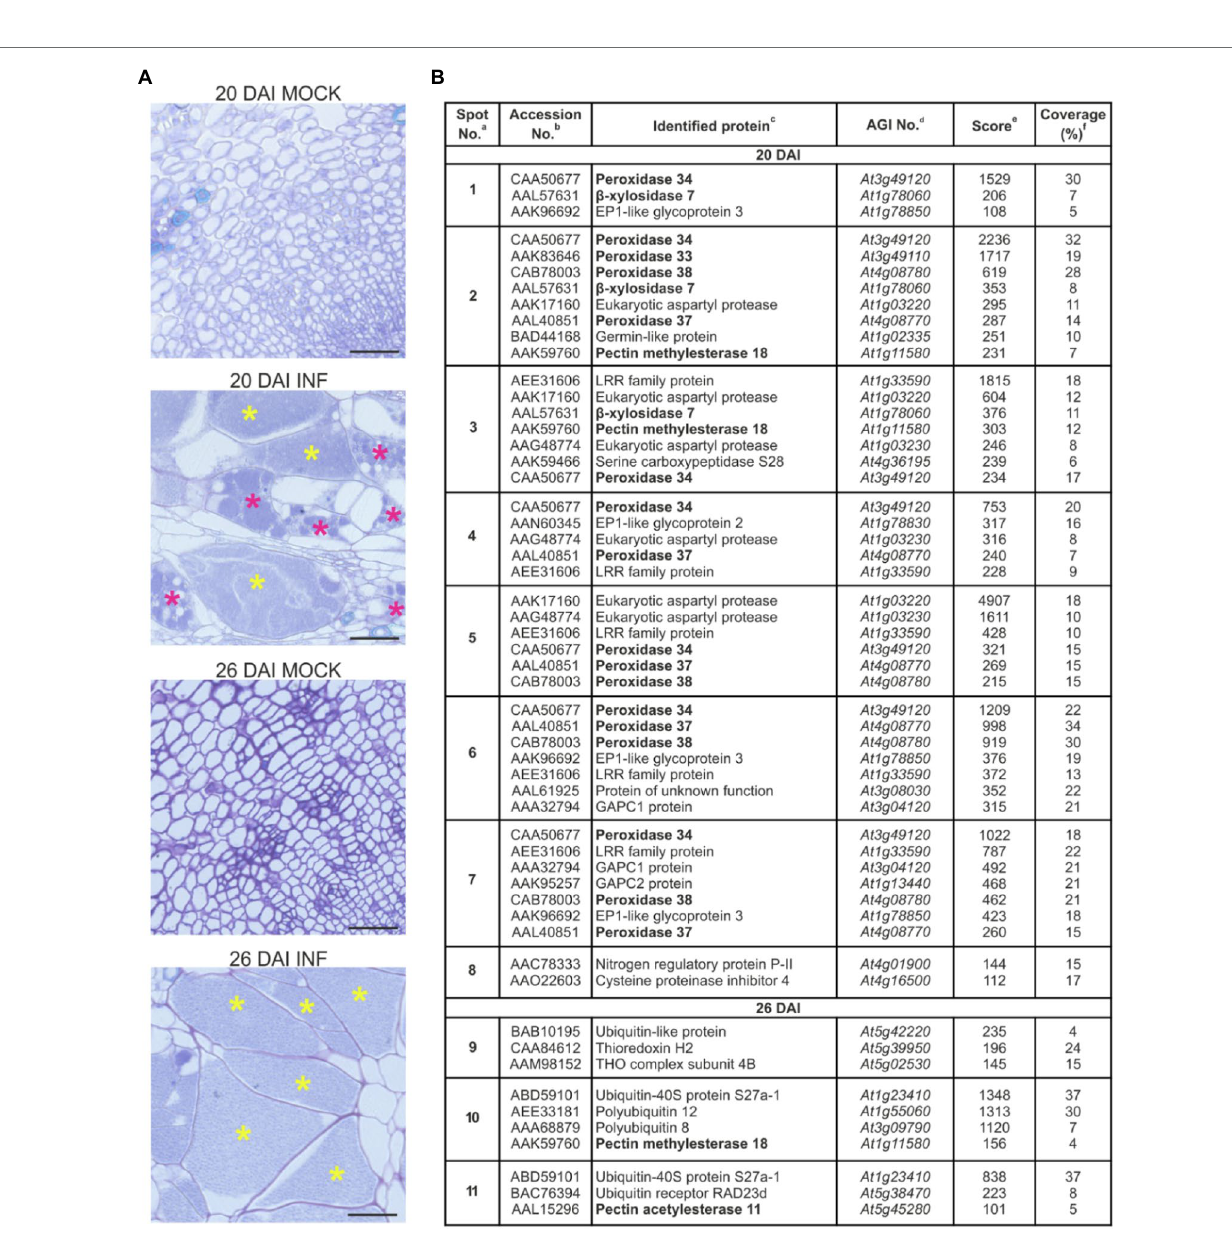
hypertrophy was reduced (by 50.6 and 61.2%; Figure 3F ) in